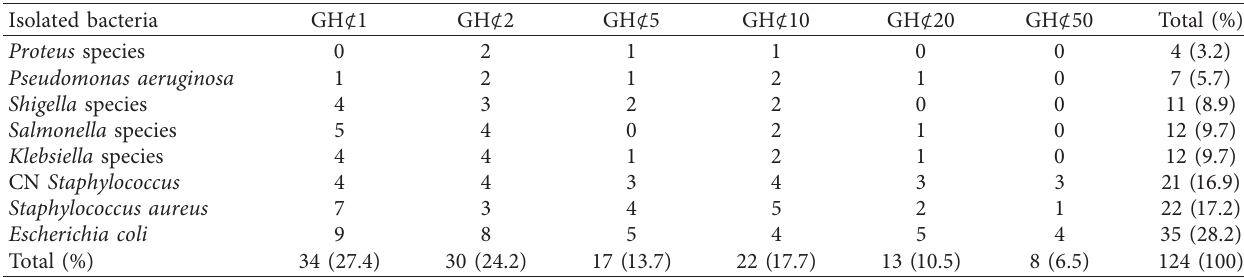
Table 3: Distribution of bacterial isolates based on the currency notes denomination.